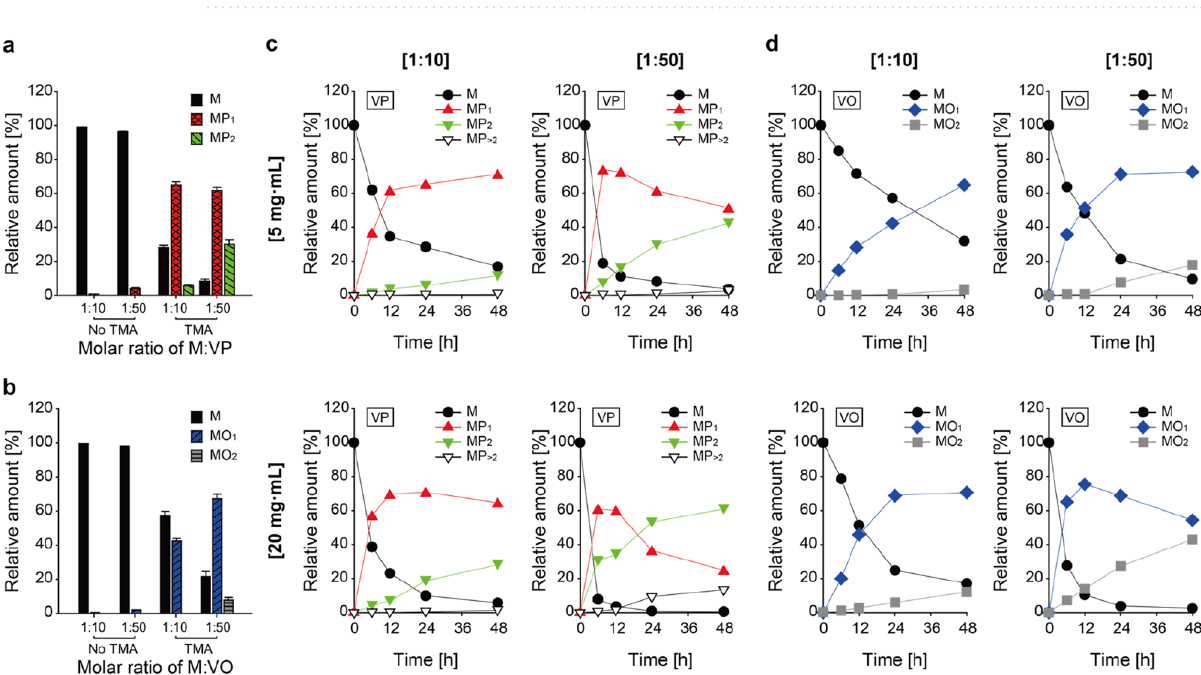
Figure 2. TMA-catalyzed myricetin acylation under various reaction conditions. ( a , b ) Investigation for effect of a chemical catalyst TMA on myricetin esterification. Acylation was performed in acetone with TMA (10 mol% of 5 mg·mL −1 myricetin) for 48 h, using ( a ) vinyl propionate (VP) or ( b ) vinyl octanoate (VO) as acyl donors. Data are expressed as the mean ± s.d. ( c , d ). Profiles of myricetin acylation where initial myricetin concentrations were 5 or 20 mg·mL −1 , and molar ratios of myricetin-to-vinyl ester were 1:10 or 1:50. The acyl donor used for each reaction is indicated in each profile. MP >2 ,